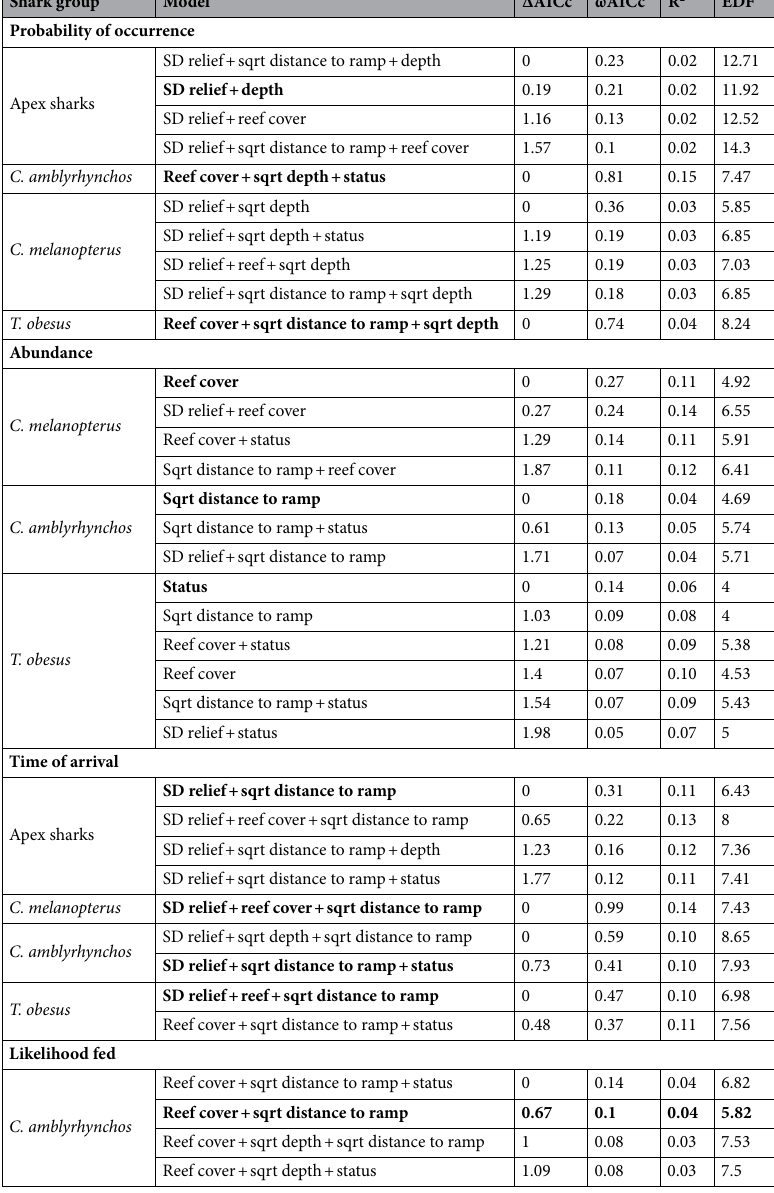
Table 2. Top Generalised Additive Mixed Models (GAMMs) for predicting probability of observation, abundance given observation and time of arrival from full-subsets analyses for the five shark groups. The difference between the lowest reported Akaike Information Criterion corrected for small sample size (AICc), AICc weights (wAICc), variance explained (R 2 ) and estimated degrees of freedom (EDF) are reported for model comparison. The most parsimonious model is shown in bold and was defined as the model that contains the fewest variables and the lowest EDF within two units of the lowest